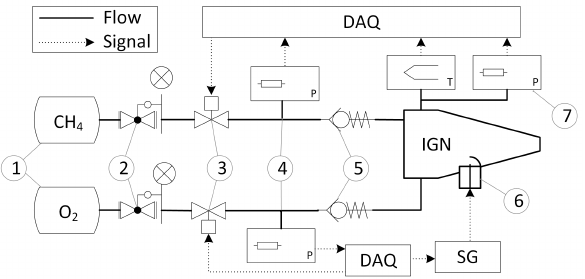
Figure A1. Ignition system